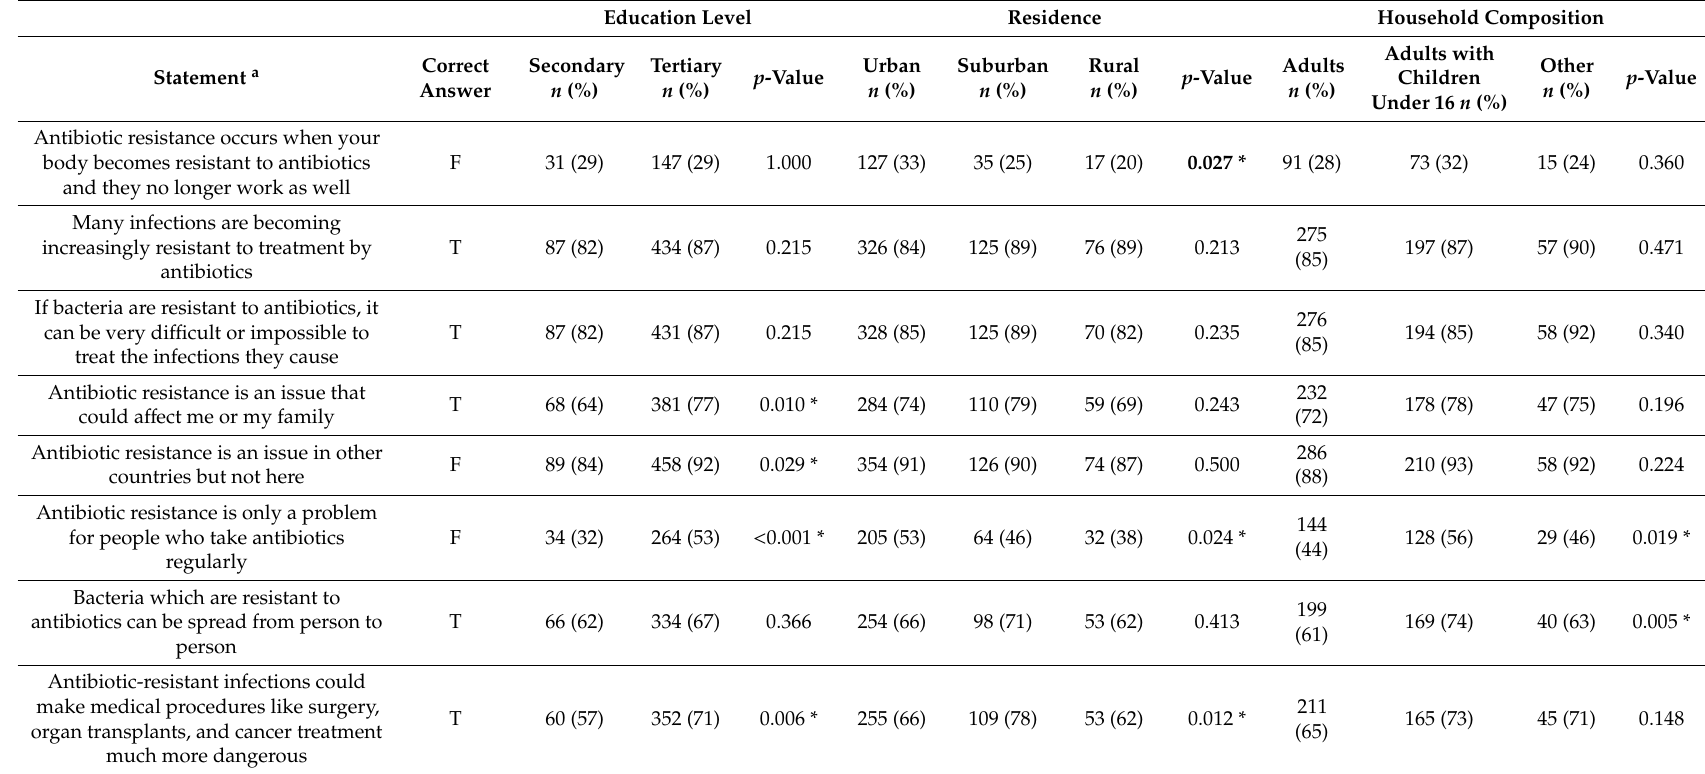
Table 2. Level of understanding of antibiotic